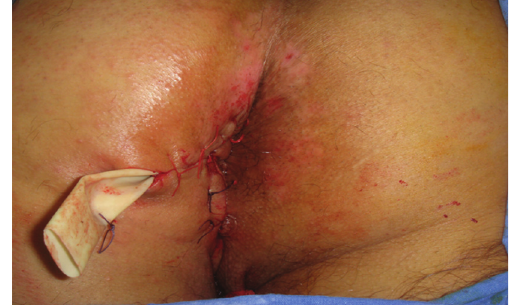
Figure 3: Postoperative